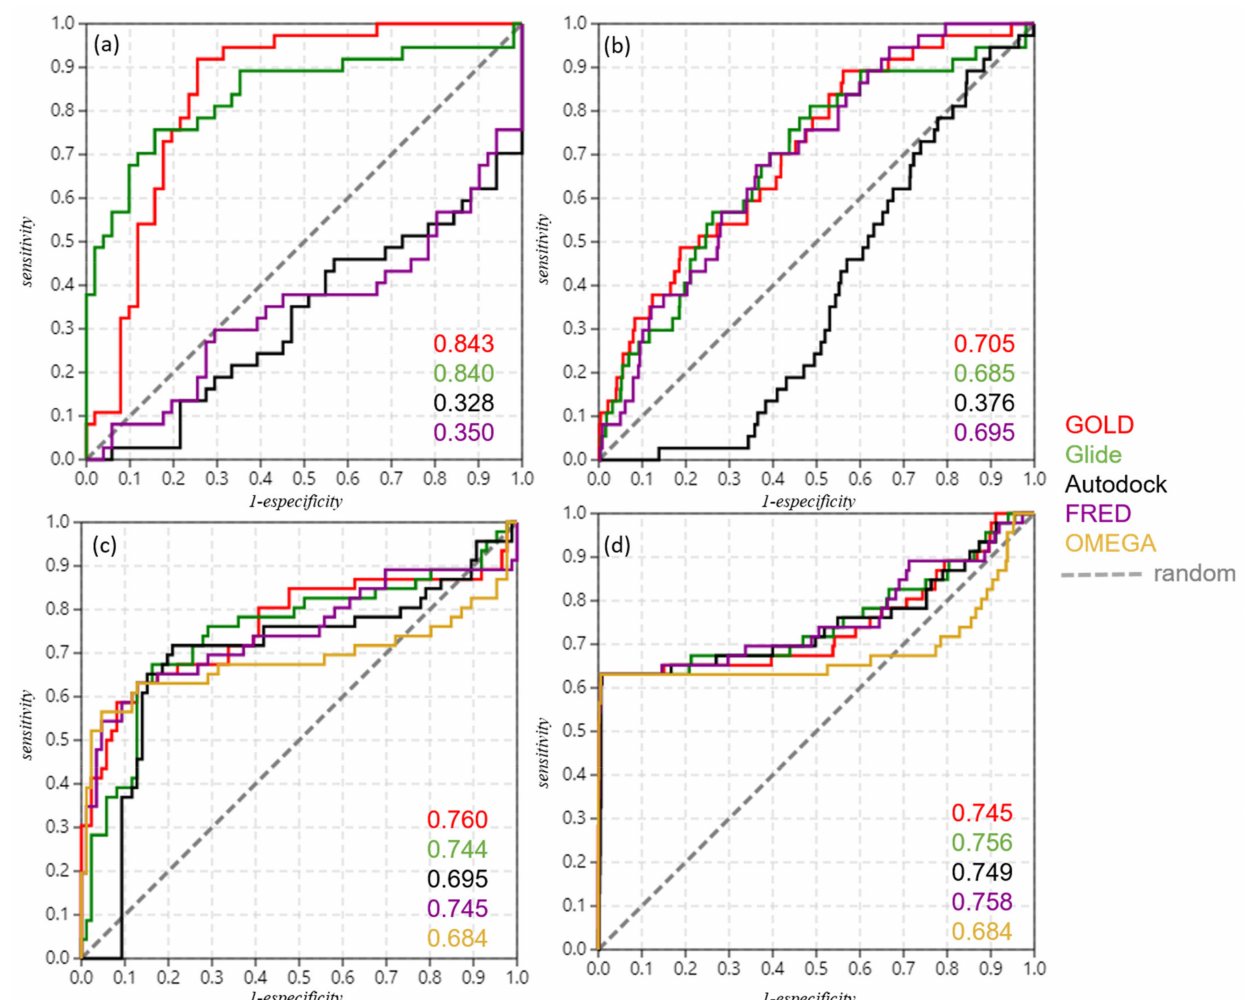
Figure 6. Docking validation by ROC curves and the respective AUC values obtained by each software using ( a ) dataset of 88 compounds and ( b ) 88 compounds plus decoys. vROCS validation by ROC curves and the respective AUC values obtained by each query of corresponding software using ( c ) dataset of 88 compounds and ( d ) 88 compounds plus